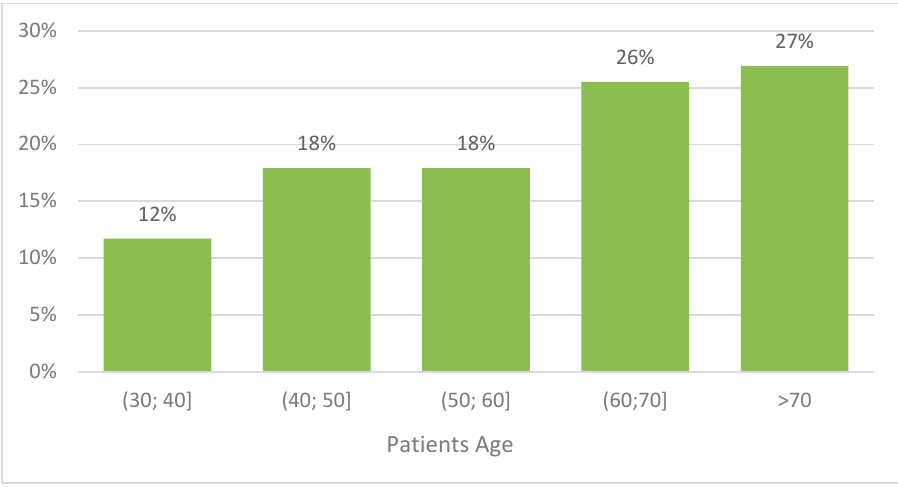
Figure 1. Age distribution of the analyzed patients.